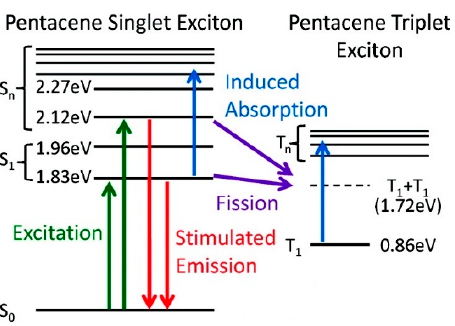
Figure 17. Energy level diagram for excitonic states in polycrystalline thin films of 69 . The labeled arrows indicate the main transitions. The energy position of the Davydov levels of the first singlet and higher-lying exciton are reported. Reprinted with permission from [69], Copyright 2011, American Chemical Society.